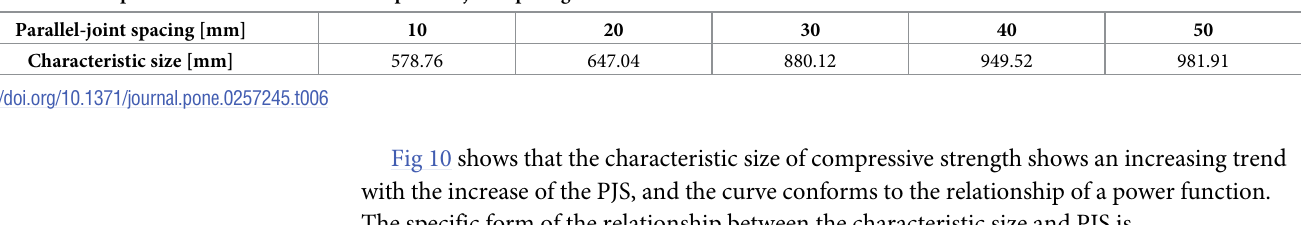
Table 6. Relationship between characteristic size and parallel-joint spacing.